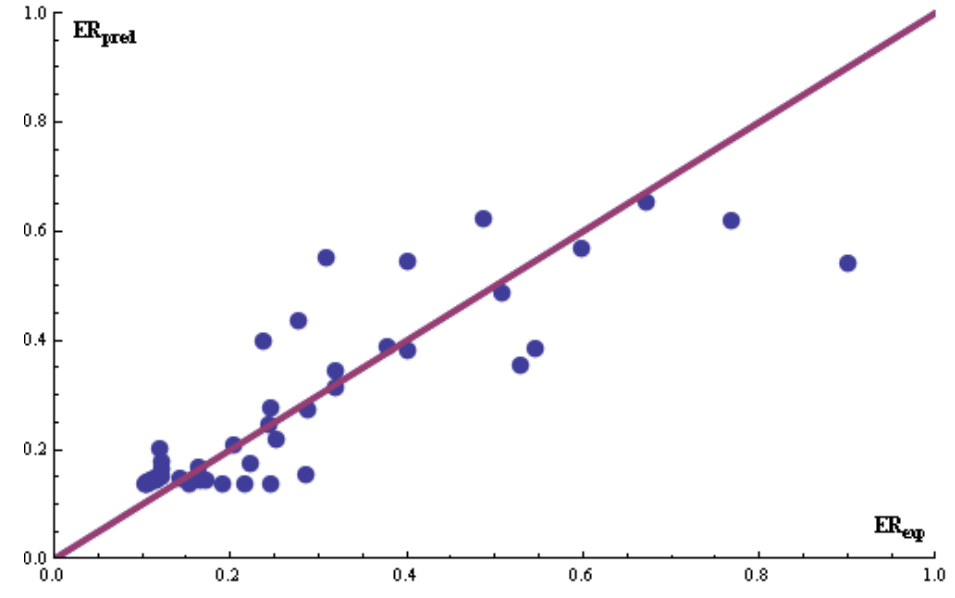
Figure 5. Training results for DB #1 ( N = 47 patterns). The ERM was used for the selection of the descriptors.